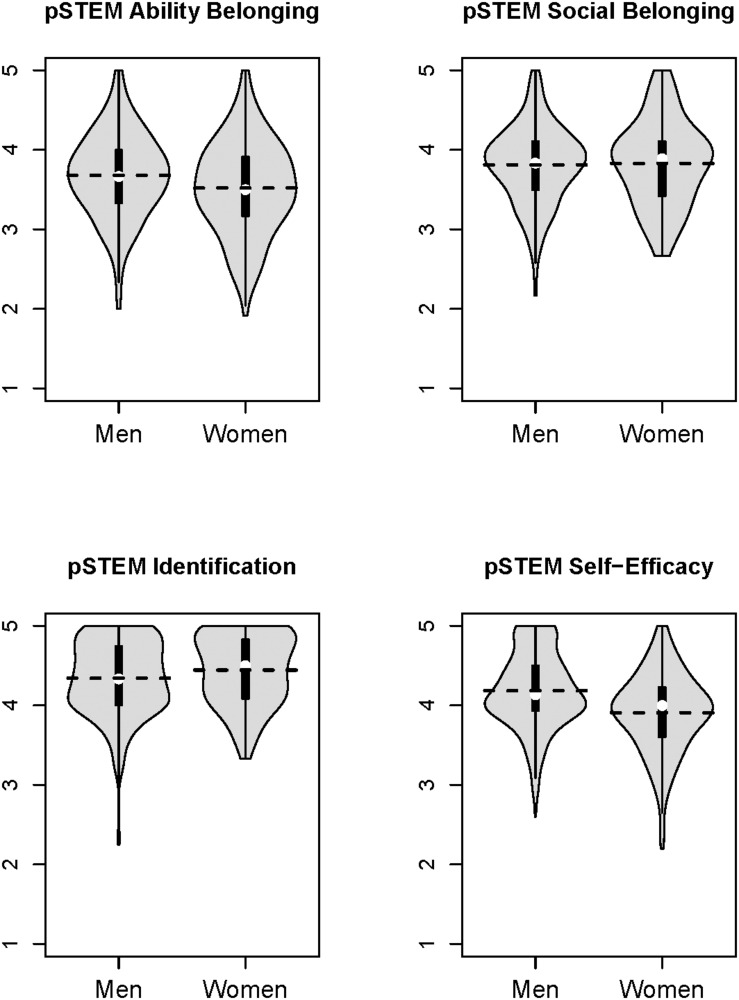
Violin plots depicting the academic self-perceptions on average over the semester for men and women. The boxplot and whiskers are in black; the white circle represents the median, and dashed horizontal lines represent the mean. The distribution of responses, in gray, is reflected on each side of the boxplot.